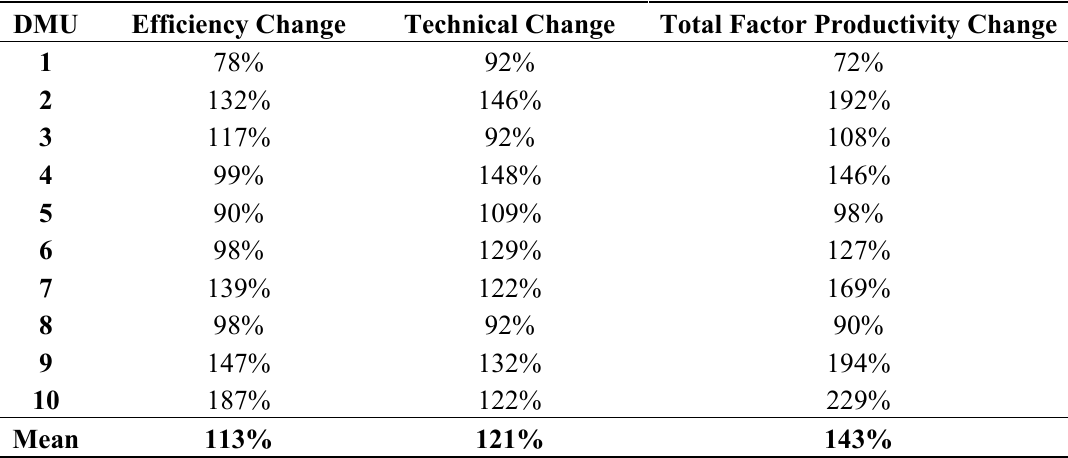
Table 7. Malmquist index summary (Natural